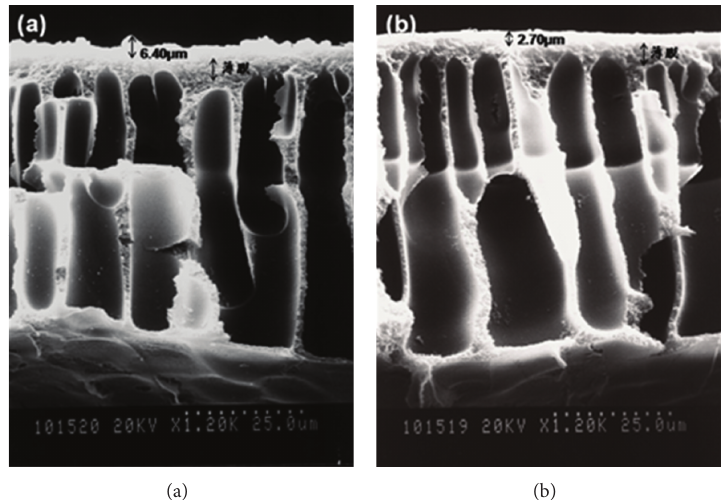
Figure 9: Profile of the UF membrane after ultrafiltration (5KD, magnified 1200x), (a) with 0wt% TiO 2 and (b) with 10wt% TiO 2 .